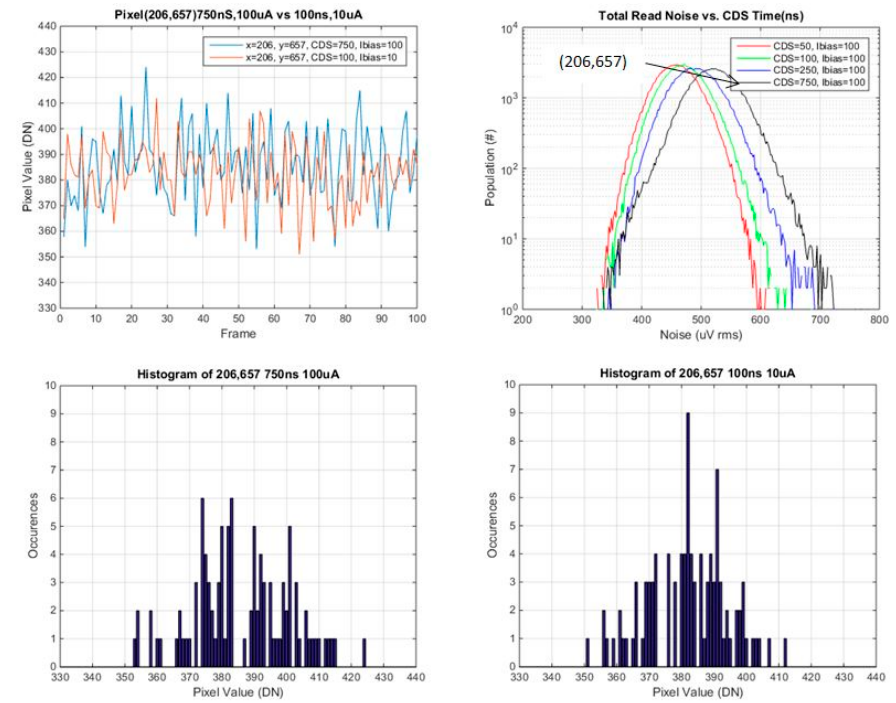
Figure 16. Pixel value vs. frame, and histogram of pixel values for pixel 206,765 (from the mode of the noise histogram).